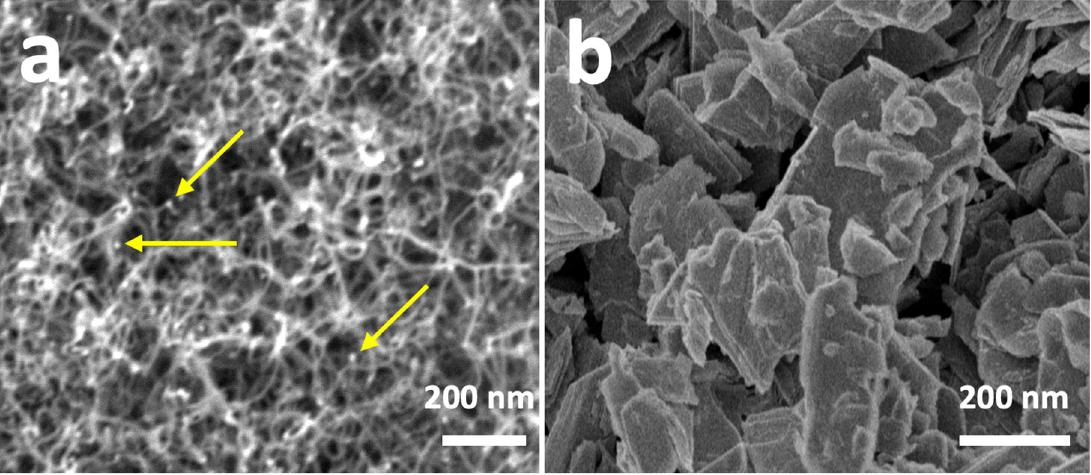
Figure 3. SEM micrographs of SWCNTs-AuNPs ( a ) and MoS 2 nanosheets ( b ). The arrows in Figure 3a indicate the presence of AuNPs.